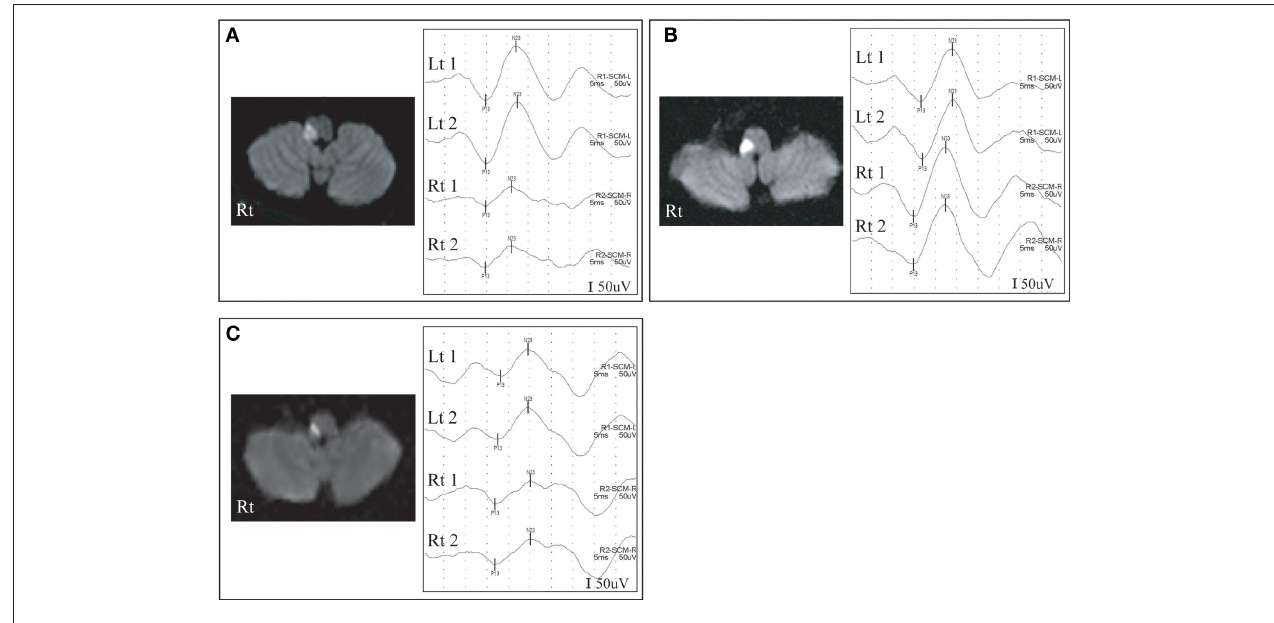
(patient 7) with right LMI exhibits delayed p13 responses in the contralesional side (b) . The other patient (patient 8) with right LMI shows delayed p13 responses and decreased amplitude in the ipsi- and contralesional side (C)